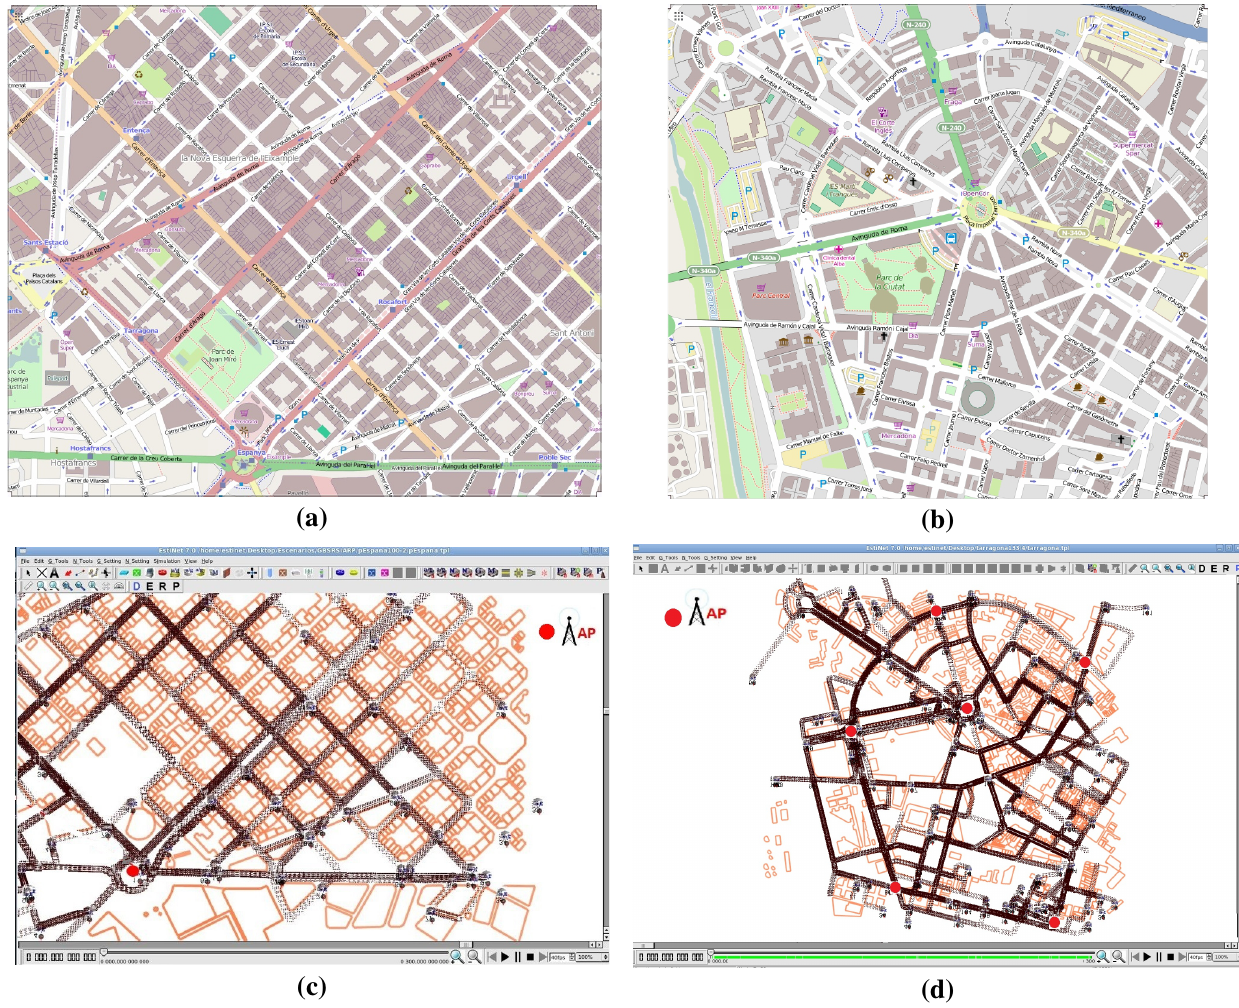
Figure 7. Simulation scenarios from two cities of Catalonia, Spain. ( a ) Example district of Barcelona from OSM; ( b ) downtown area of Tarragona from OSM; ( c ) barcelona simulated scenario with an access point (AP); buildings from OpenStreetMap are included. ( d ) Tarragona simulated scenario with six APs; buildings from OpenStreetMap are